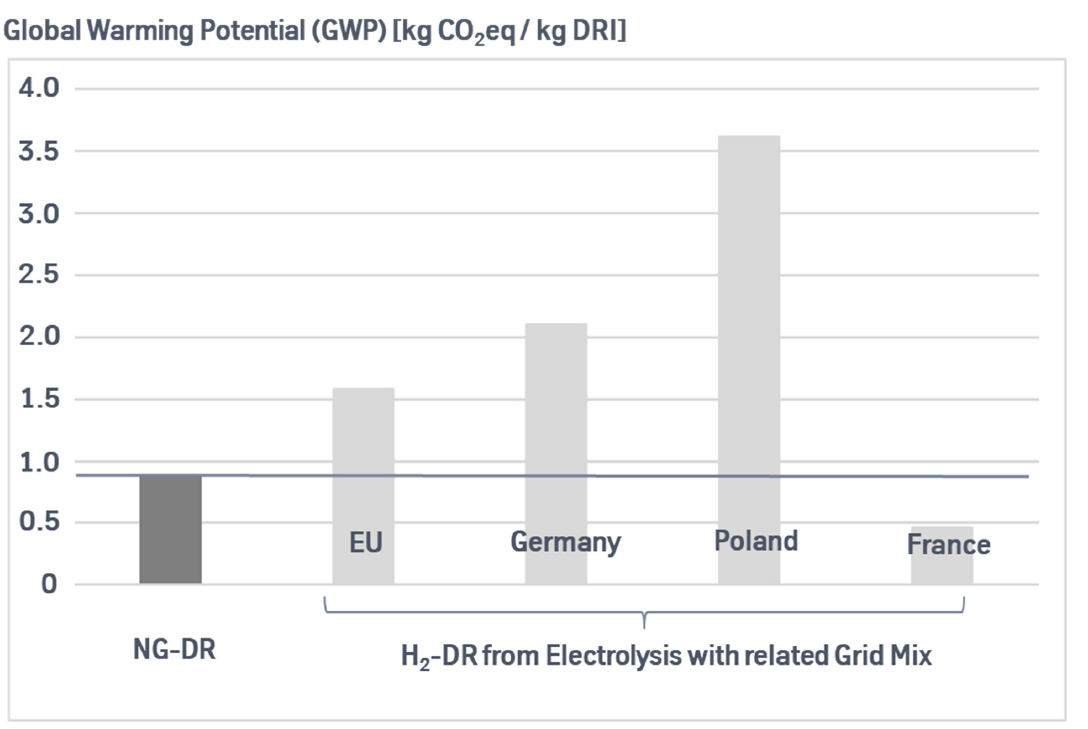
Figure 8. Carbon footprint of direct reduced iron (DRI) depending on the origin of the electricity mix that is used for hydrogen electrolysis for the year 2018. The corresponding electricity mix carbon footprint and the resulting hydrogen carbon footprint are listed in Figure 3.